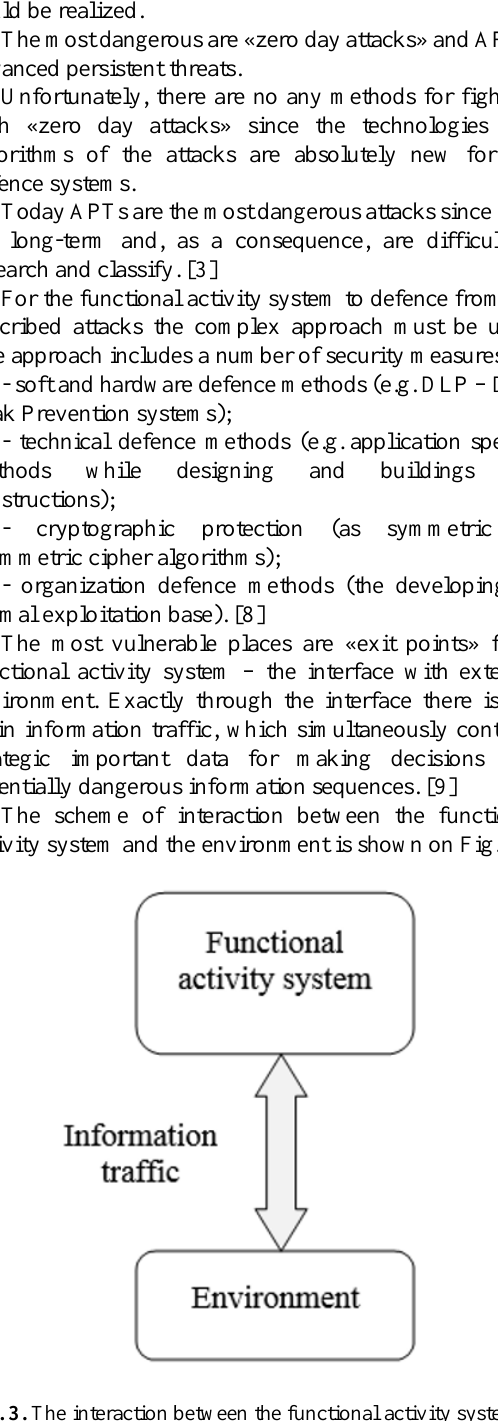
Fig. 3. The interaction between the functional activity system and the